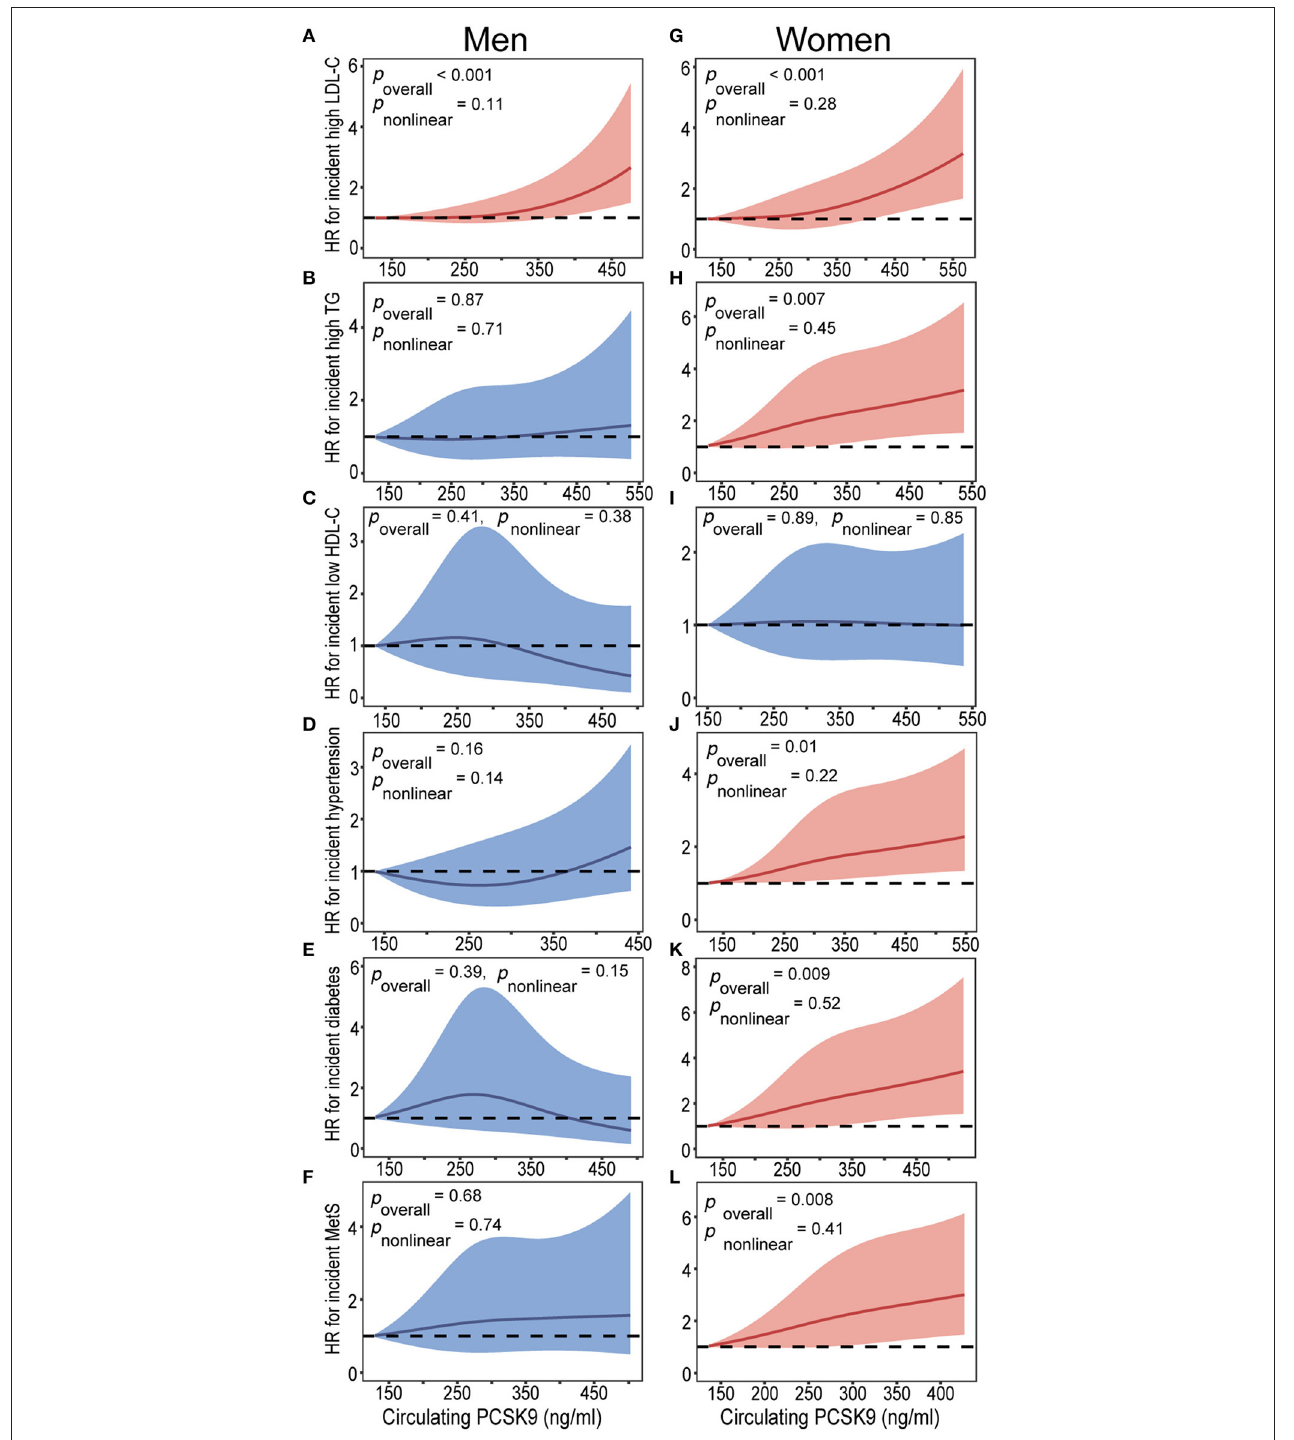
FIGURE 3 | Baseline circulating PCSK9 levels on a continuous scale and incidence of cardiometabolic risk factors in men (A-F) and women (G-L) . Cardiometabolic risk factors including high LDL-C (A,G) , high triglycerides (B,H) , low HDL-C (C,I) , hypertension (D,J) , type 2 diabetes (E,K) , and metabolic syndrome (F,L) . Hazard ratios (HRs) are indicated by solid lines and 95% confidence intervals (CIs) by shaded areas. Model was adjusted for age, current smoking status, alcohol consumption, physical activity, educational attainment, BMI, waist circumference, C-reactive protein, fasting plasma glucose, post-loading plasma glucose, HOMA-IR, systolic blood pressure, diastolic blood pressure, and lipid profiles. Subgroup variable was excluded from the model. LDL-C, low-density lipoprotein cholesterol; TG, triglycerides; HDL-C, high-density lipoprotein cholesterol; MetS, metabolic syndrome; PCSK9, proprotein convertase subtilisin/kexin type 9.